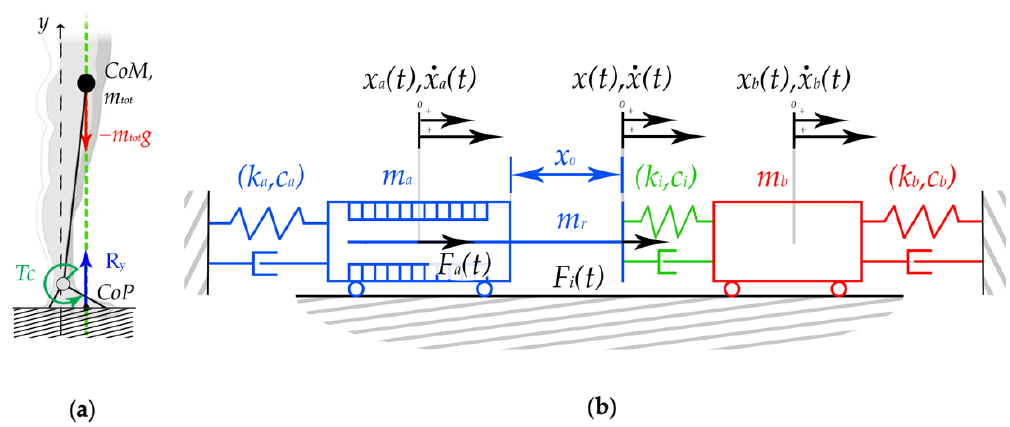
Figure 2. ( a ) Human body’s reaction to low balance disturbances; ( b ) model of the system during strike phase for control application: actuator (in blue), interface (in green), target body (in red), state and measured variables (in black). Table 2. Modeled system key parameters list. Symbols refer to Figure 2b. All displacements are referred to the respective equilibrium positions.